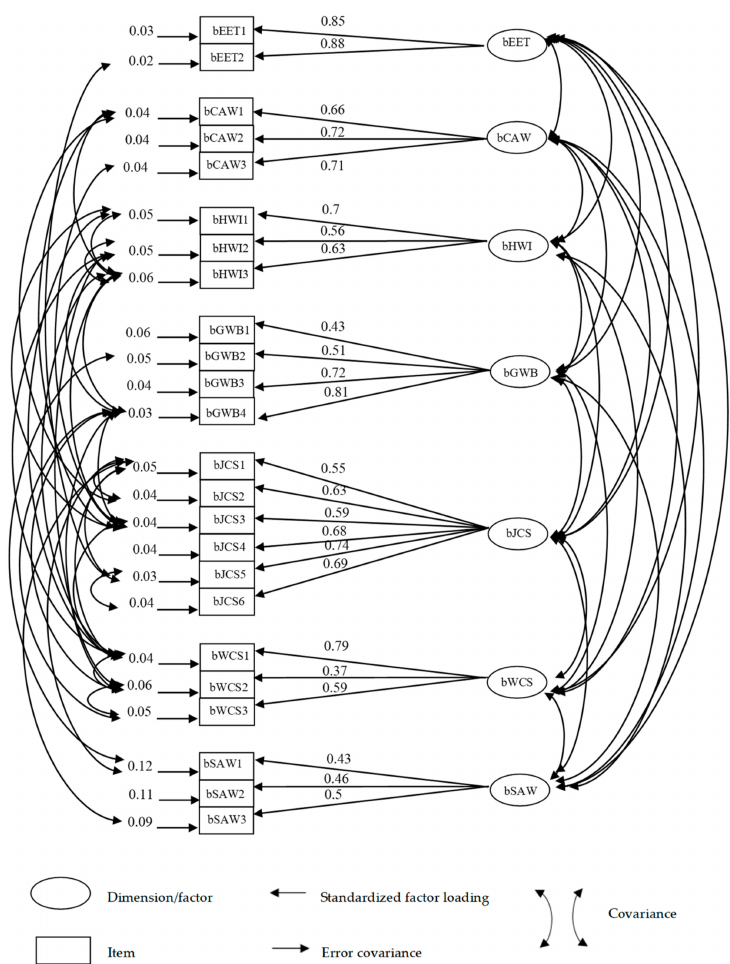
Figure 1. Confirmatory factor analysis of the seven-factor, 24-item brief THWRQLS model ( n = 250). goodness-of-fit statistics for the structure model: χ 2 = 268.77, p -value < 0.01, CFI = 0.97, RMSEA = 0.04, SRMR = 0.05.